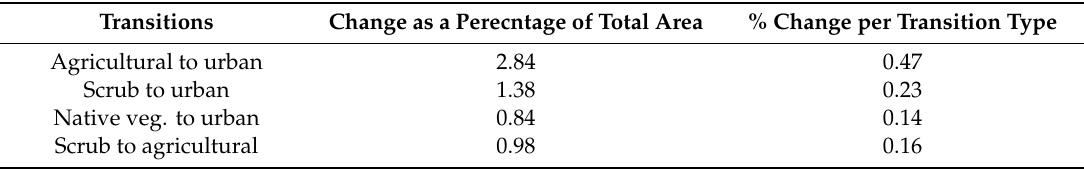
Table 3. Transitions to urban and agricultural land use from 1998–2017.